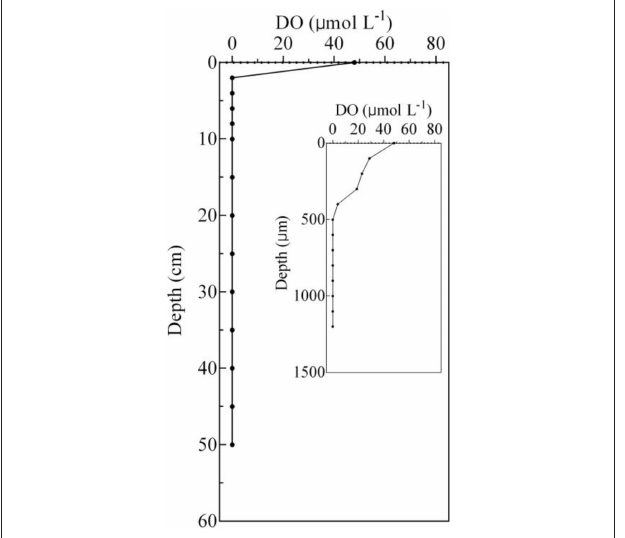
FIGURE 2 | Vertical distribution of DO in the sediment cores, which was detected in July 2015.